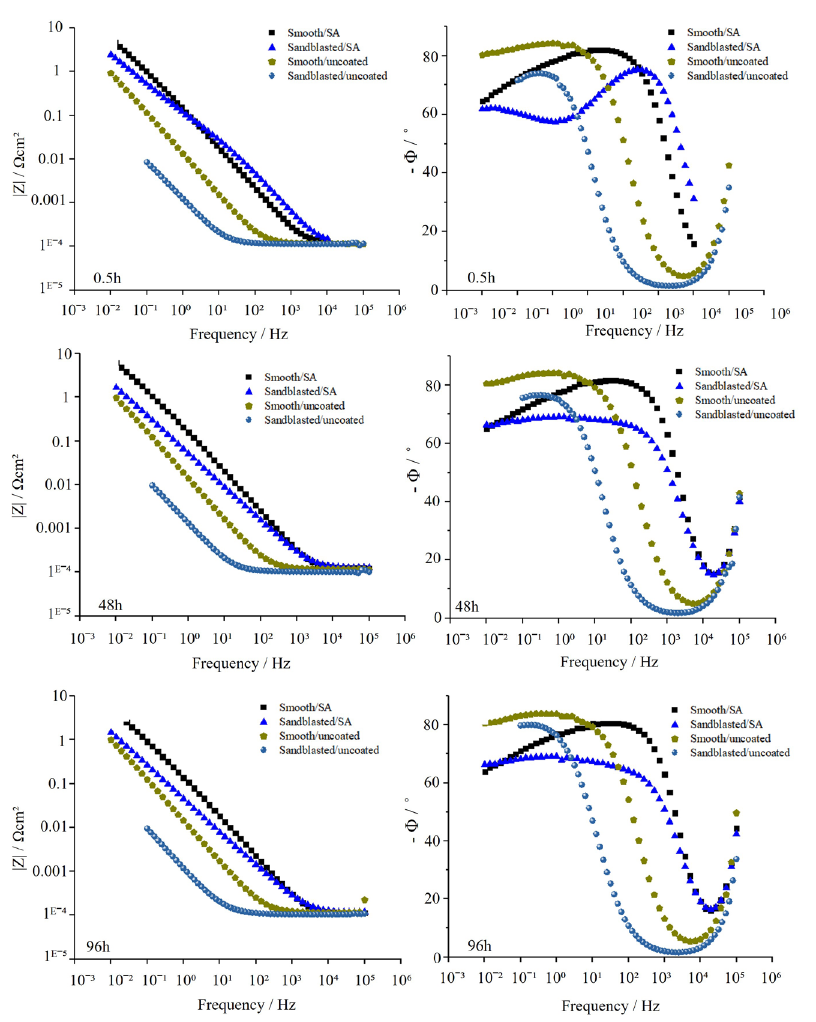
Figure 5. Bode diagrams of the samples with the smooth and sandblasted substrate with SA coating compared to the uncoated substrates analyzed in 0.5 h, 48 h, and 96 h of immersion in 0.1 mol / L NaCl